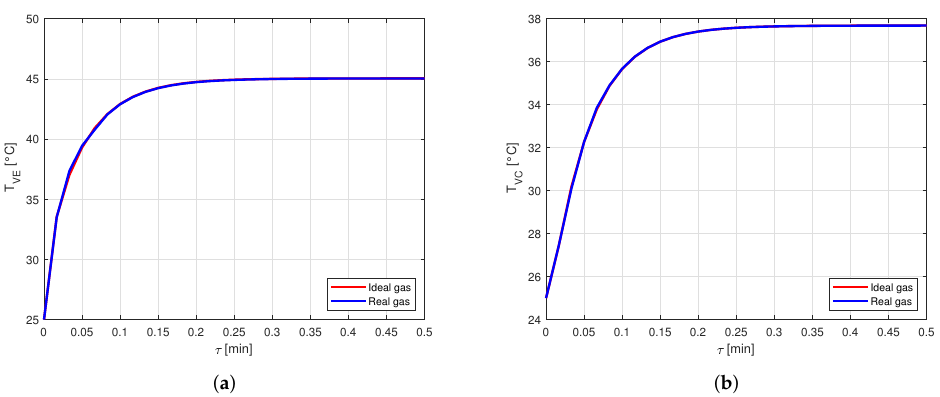
Figure 9. Comparison between the vapor temperatures obtained by modeling the vapor as ideal or real gas, in a copper-water heat pipe ( a ) Comparison of the vapor temperatures at the evaporator. ( b ) Comparison of the vapor temperatures at the condenser.